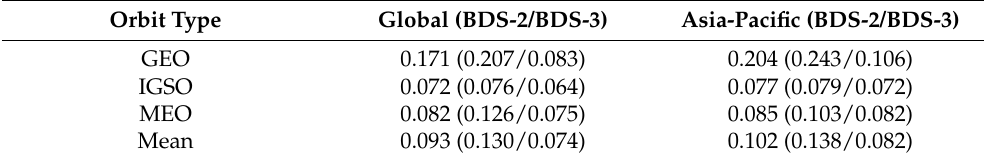
Table 3. BDS-2/3 clock offset accuracy statistics of various orbits in Global/Asia-Pacific (unit: ns). Orbit Type